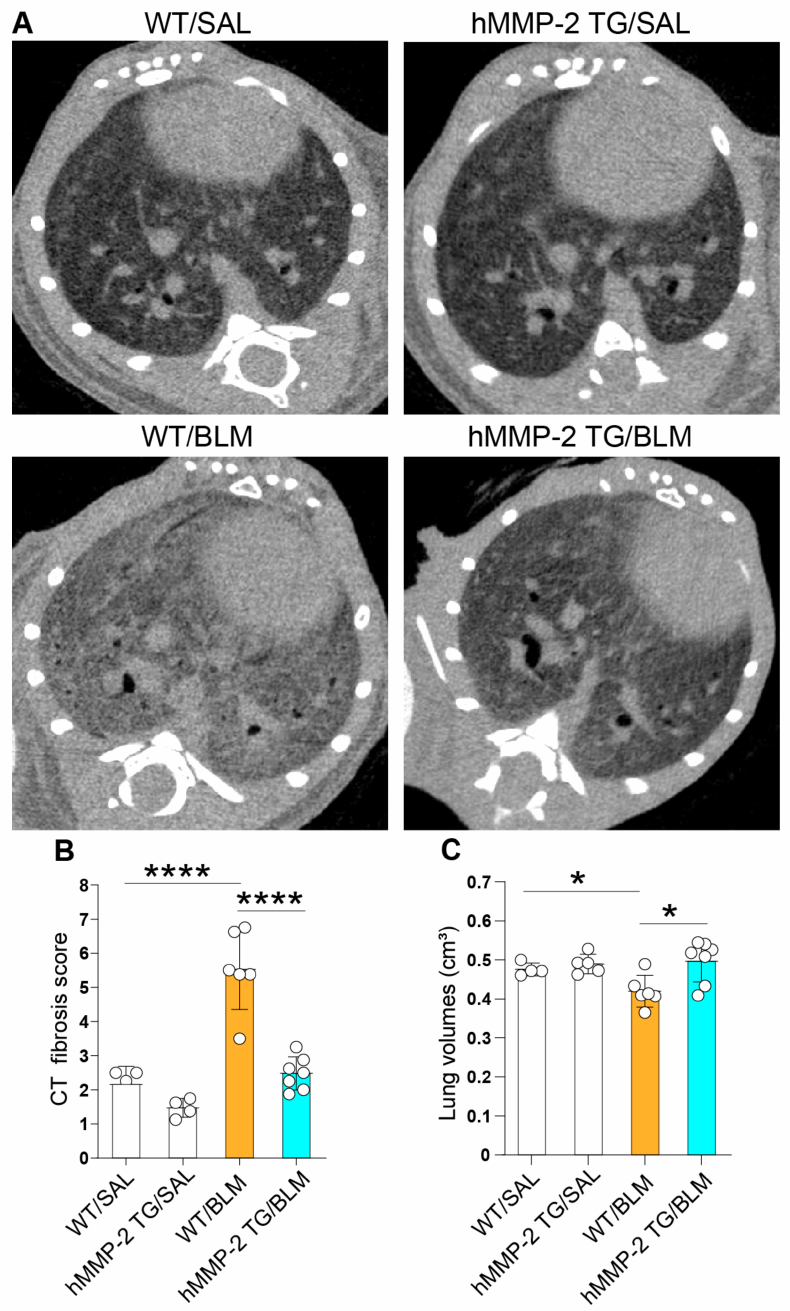
Figure 5. Amelioration of CT score of lung fibrosis and lung volumes in hMMP-2 TG mice. MicroCT was performed, and the radiological findings of fibrosis were scored by experts blinded to the treatment groups ( A , B ). Lung volumes were measured using microCT software ( C ). The number of mice: n = 4 in WT/SAL and hMMP-2 TG/SAL, n = 6 in WT/BLM, and n = 7 in hMMP-2 TG/BLM. Data are the mean ± S.D. All mice were female. Statistical analysis by ANOVA with Newman-Keuls test. **** p < 0.0001; * p < 0.05. CT computed tomography; WT, wild-type; hMMP-2, human matrix metalloproteinase-2; SAL, saline; BLM, bleomycin; TG,